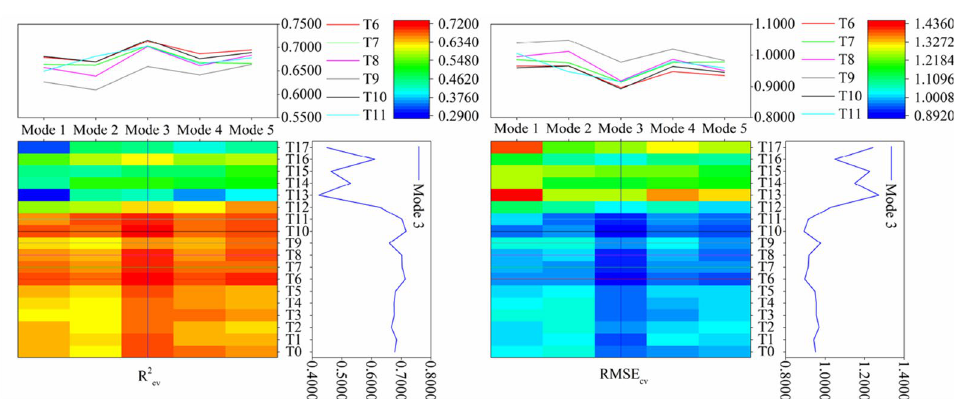
Figure 5. Construction of PLSR models in different